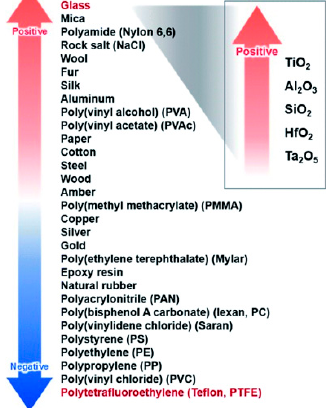
Figure 10. Electrification scale for triboelectric series design [35].